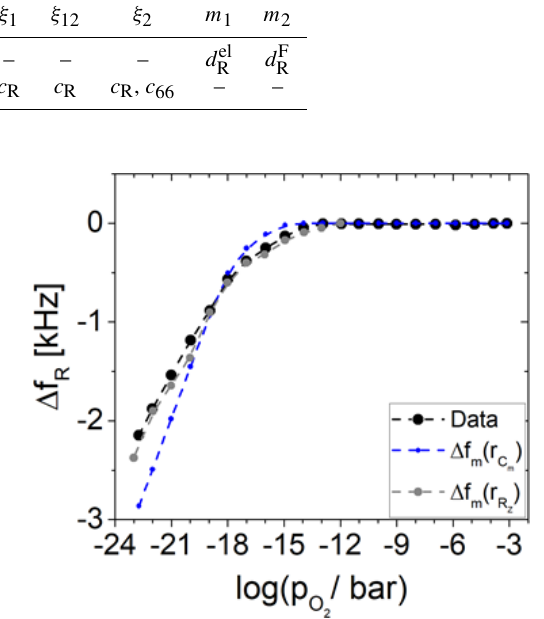
Figure 9. Effective electrode radius r R of different lumped ele- ments of the BvD EC in dependence of the oxygen partial pres- sure p O . Measured data from Fritze et al. (2005) are compared 2 to calculations using different resonator resistances R Res . In addi- tion, r R for the real part of the impedance at the resonance frequency is shown.